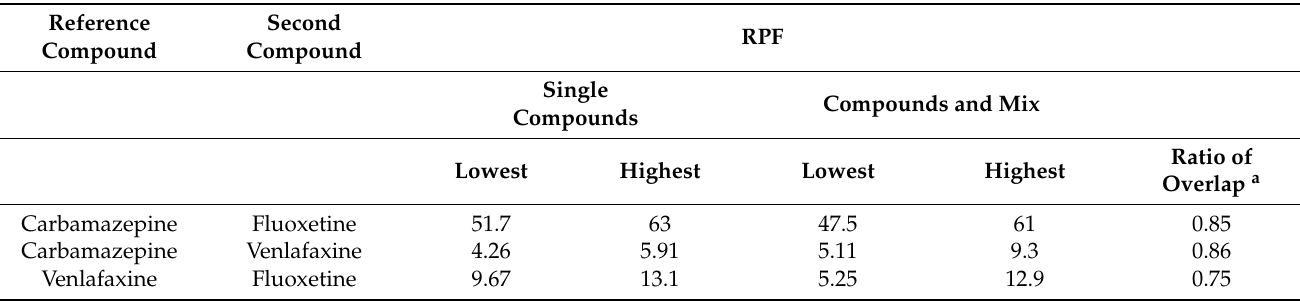
Table 4. Quantitative evaluation of the dose addition: effect of mixtures on RPF of single compounds.